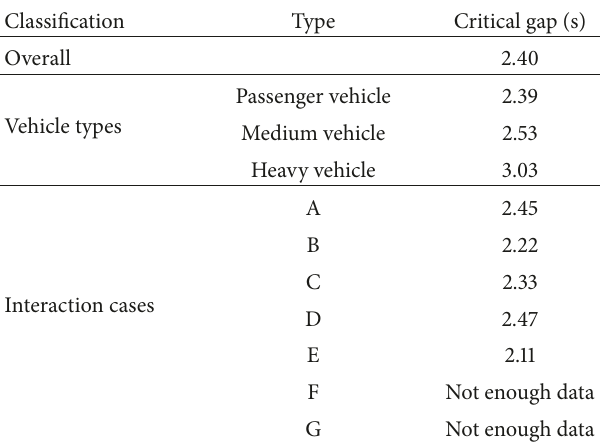
Table 3: Summary of critical gap